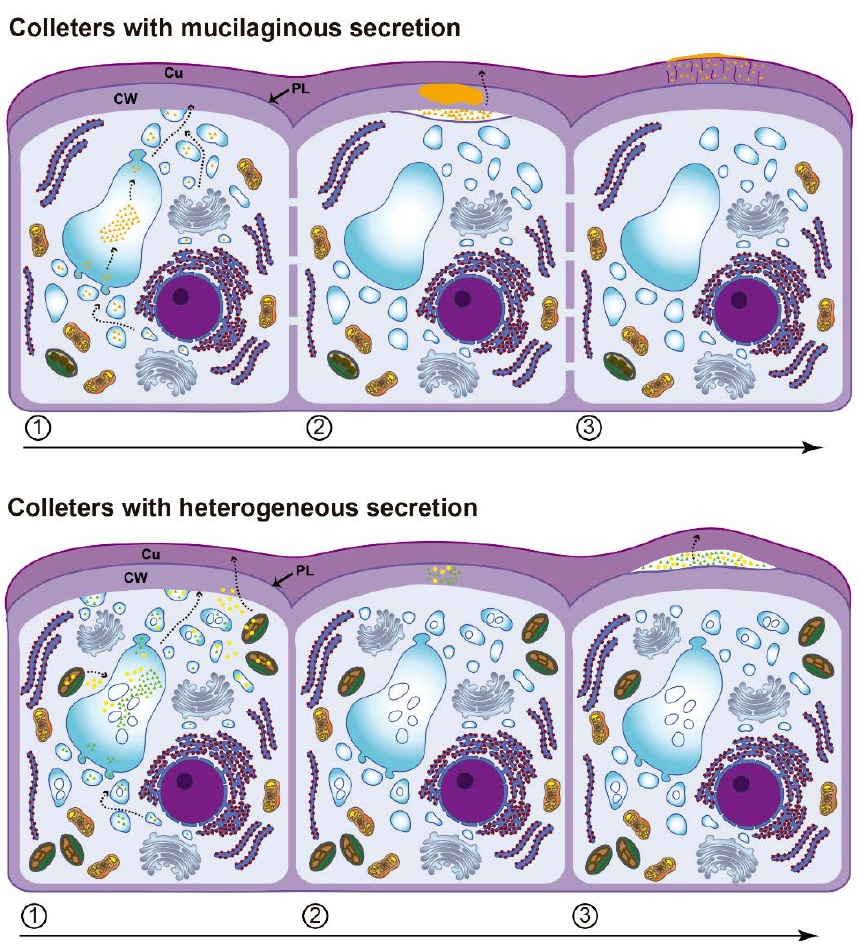
Figure 7. Schematic sequence of three moments of the secretion release in colleters with mucilaginous exudate and those with heterogeneous exudate. Cu = cuticle; CW = cell wall; PL = pectin